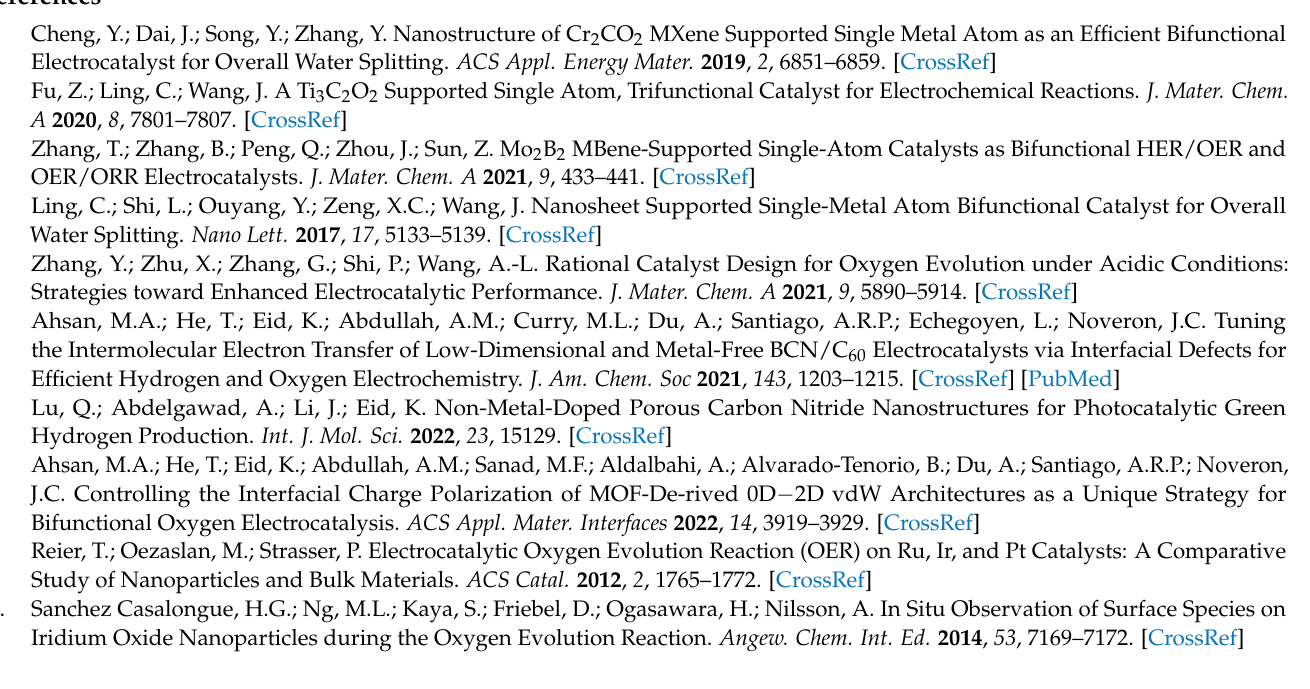
on Pt/Cr@Mo 2 TiC 2 O 2 h-DACs, red lines represent the energy-favored reaction pathways, Figure S8. The diagram of all possible ORR pathways and corresponding Gibbs free energy on Pt/Fe@Mo 2 TiC 2 O 2 h-DACs, red lines represent the energy-favored reaction pathways, Figure S9. The diagram of all possible ORR pathways and corresponding Gibbs free energy on Pt/Co@Mo 2 TiC 2 O 2 h-DACs, red lines repre- sent the energy-favored reaction pathways, Figure S10. The diagram of all possible ORR pathways and corresponding Gibbs free energy on Pt/Cu@Mo 2 TiC 2 O 2 h-DACs, red lines represent the energy-favored reaction pathways, Figure S11. The diagram of all possible ORR pathways and corresponding Gibbs free energy on Pt/Zn@Mo 2 TiC 2 O 2 h-DACs, red lines represent the energy-favored reaction pathways, Figure S12. The configurations of oxygenated intermediates in energy-favored reactions pathways of OER on Pt/Cr@Mo 2 TiC 2 O 2 h-DACs. The red line represents the most energy-consuming step, Figure S13. (a) The Projected DOS and the location d-band center of Pt atom for Pt@Mo 2 TiC 2 O 2 , Pt/Cr@Mo 2 TiC 2 O 2 and Pt-O-Cr@Mo 2 TiC 2 O 2 h-DACs. (b) The electronic DOS (per atom) of Pt/Cr@Mo 2 TiC 2 O 2 h-DACs and Pt/Ni@Mo 2 TiC 2 O 2 h-DACs, Table S1. ∆ GH* of different H adsorption sites on the Pt/TM@Mo 2 TiC 2 O 2 DACs surface (TM = Ti, V, Cr, Fe, Co, Ni, Cu and Zn). Wherein, “x” represents structural instability after H proton adsorbed to the site. “-” represents the non-existent sites, Table S2. The number of the charge transfer (Qe, e) from Sigle-atom to